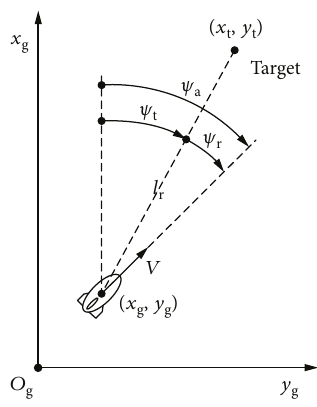
Figure 2: Coordinate frame of the relative state between the airship and the